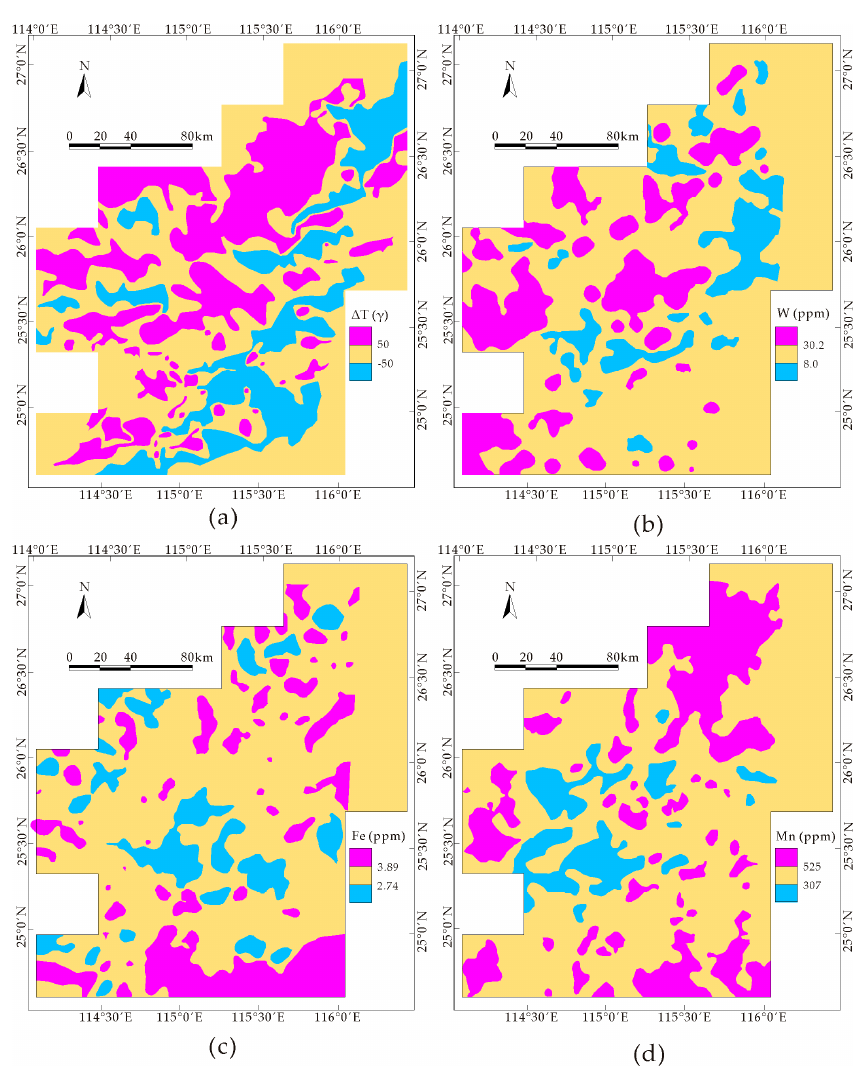
Figure 10. Geophysical and geochemical anomalies used for weights-of-evidence (WofE) analysis: ( a ) magnetic anomalies; ( b ) tungsten anomalies; ( c ) iron anomalies; and ( d ) manganese anomalies.